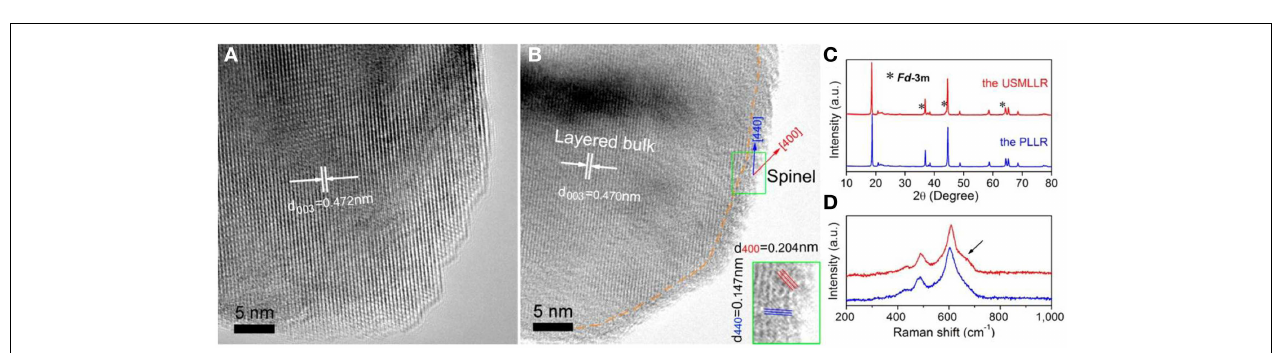
enlarged view in green rectangle of (B) . XRD patterns (using Cu K α radiation) (C) and Raman spectroscopies (D) of the PLLR sample and the USMLLR sample. Reproduced with permission fromWu et al.